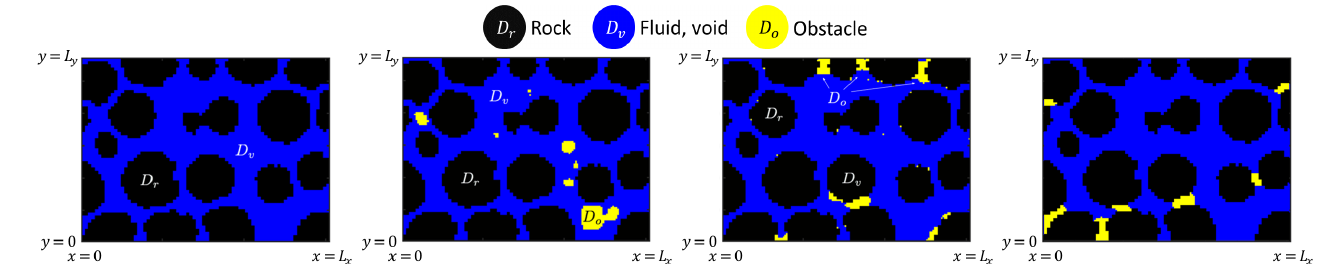
Figure 3. Many-pore geometry with obstructions. D is a vertical slice from µ -CT column, with M = 152 × 114 voxels. With voxel size equal h × h , we have | D r | = 9404 h 2 , | D f | = 7924 h 2 , and φ 0 ≈ 0.457. Rock D r is in black, fluid space D v is in blue, and obstructions D o are yellow. Left: unobstructed pore geometry with D f = D v and D o = ∅ . Middle, right, and far right: pore-filling (middle) and pore-coating (right) obstructions | D o | = 396 h 2 and V o ≈ 0.05 generated by lattice at pore scale, LP algorithm. Far right: pore-coating obstructions simulated with direct numerical simulation (DNS) method for biofilm nutrient denoted later as BN.